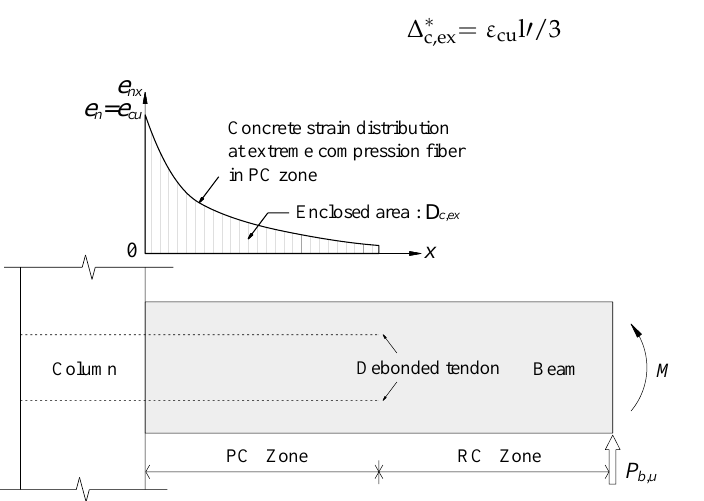
Figure 9. Concrete strain distribution at extreme compression fiber in PC zone.